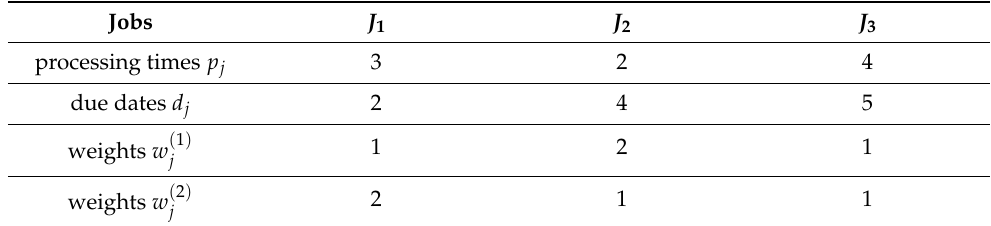
Table 3. Job Instance I 2 for Algorithm